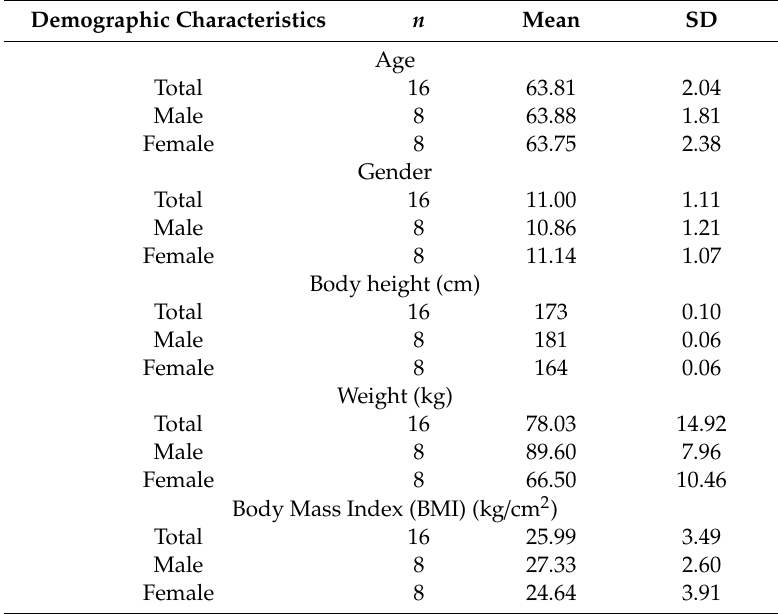
Table 1. Study population: baseline demographic